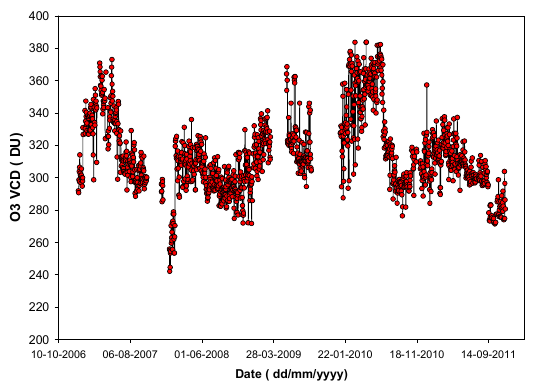
Figure 2. Time series of the O 3 VCD obtained with the SPATRAM equipment installed at Évora Observatory during 2007 -2011 period.